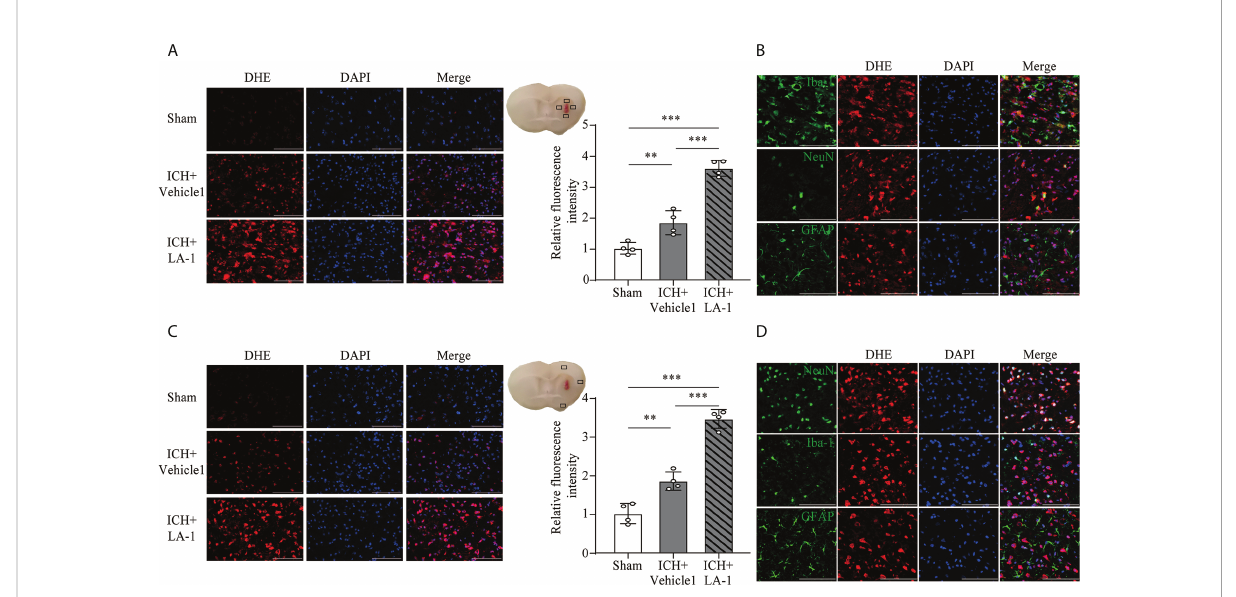
FIGURE 4 The effect of CR3 activation on oxidative stress after ICH . (A, C) Representative microphotographs and quantitative analysis of relative fl uorescence intensity of DHE in perihematomal area and ipsilateral cerebral cortex. n = 4. **P <0.01, ***P <0.001 by one-way ANOVA. (B) Representative microphotographs of immuno fl uorescence double staining showing the localization of DHE with Iba-1 (microglia marker), NeuN (neuronal marker), and GFAP (astrocyte marker) in the perihematomal area after ICH. n = 4. (D) Representative microphotographs of immuno fl uorescence double staining showing the localization of DHE with Iba-1 (microglia marker), NeuN (neuronal marker), and GFAP (astrocyte marker) in the ipsilateral cerebral cortex after ICH7d. n = 4. Scale bar = 100 m m. Data are represented as mean ±